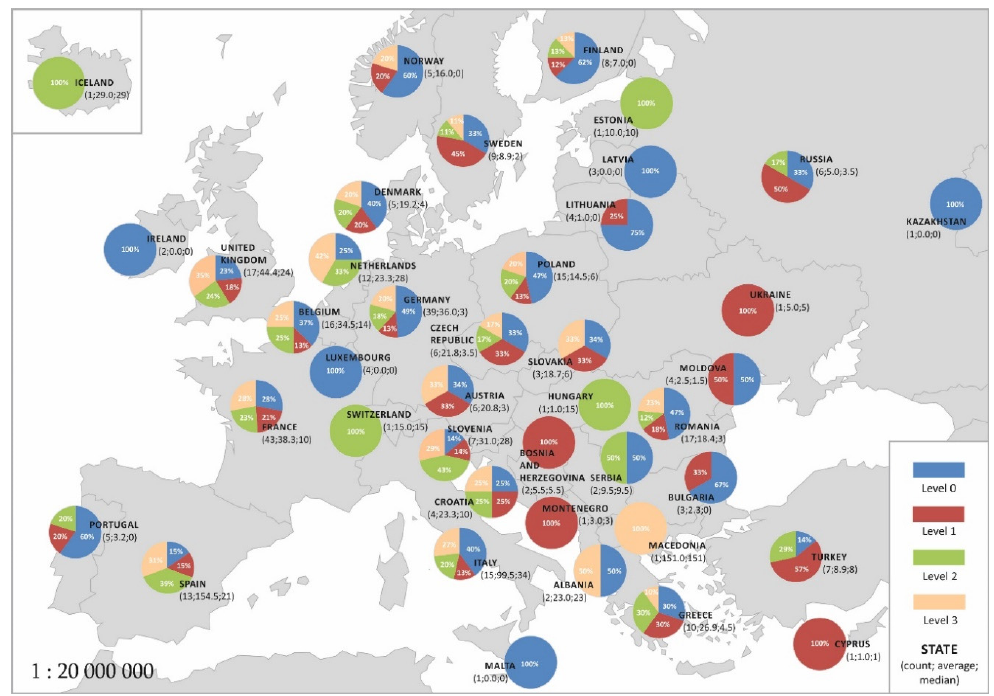
Figure 3. Results of statistical analysis for the number of partnerships in the studied promotional events, depending on the country in which the event took place. Source: own study.